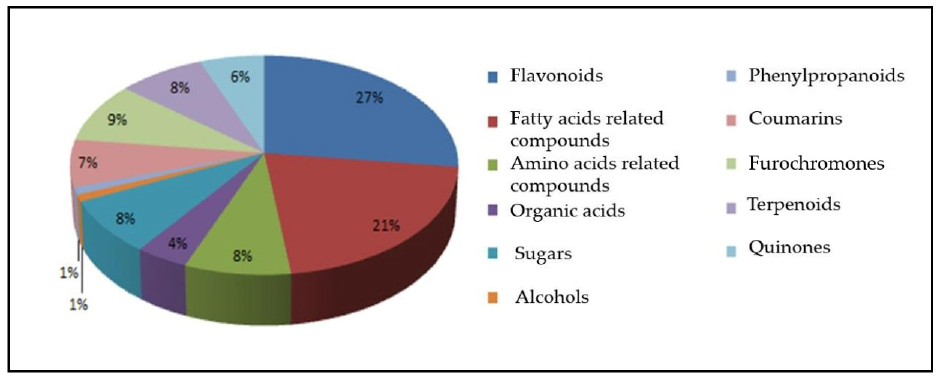
Figure 1. Numbers (as % of total) of bioactive compounds (by class) that were detected in E. longistipitata leaves.